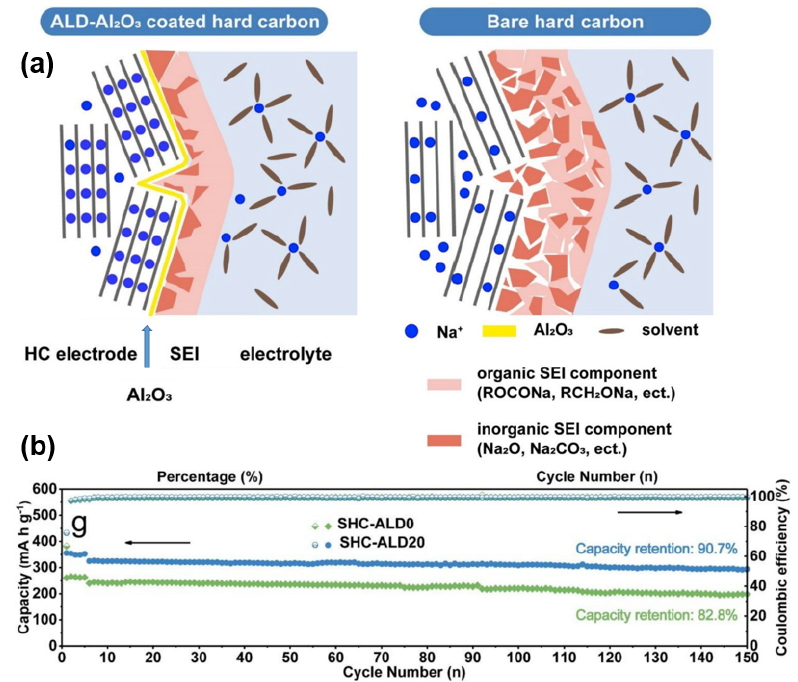
Figure 15. ( a) Schematic diagram of the influence of an ALD–Al 2 O 3 coating on the surface of SEI on HC. ( b ) Cycling performance of HC with or without an ALD–Al 2 O 3 coating at a current rate of